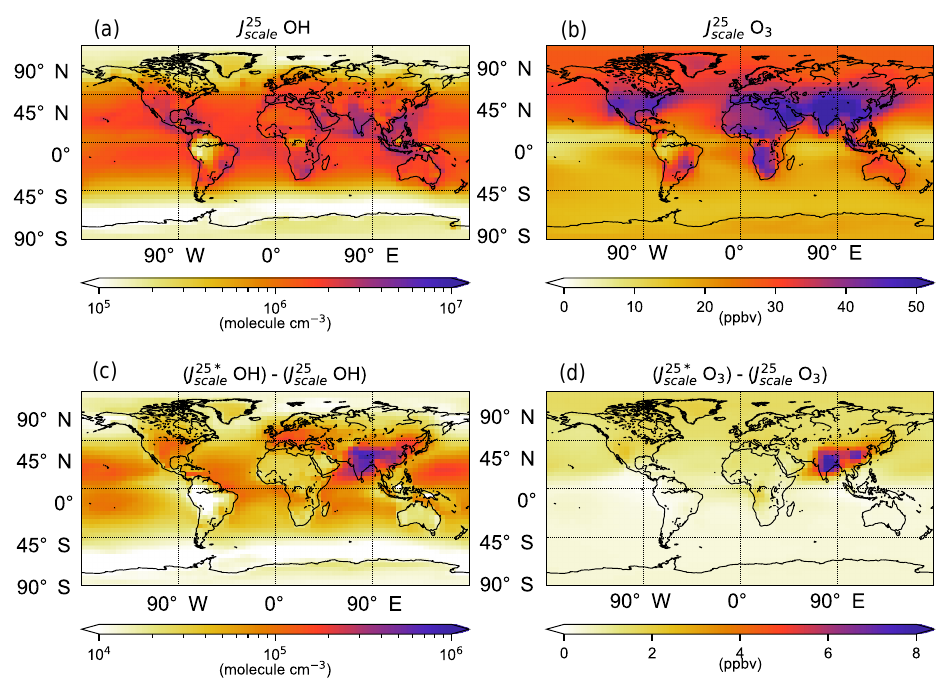
Figure 12. Simulated 2014–2015 boundary-layer-average (average over bottom 1km) OH and O 3 mixing ratios for the J 25 and b , respectively), and changes in OH and O 3 mixing ratios ( c and d , respectively) when NIT photolysis is